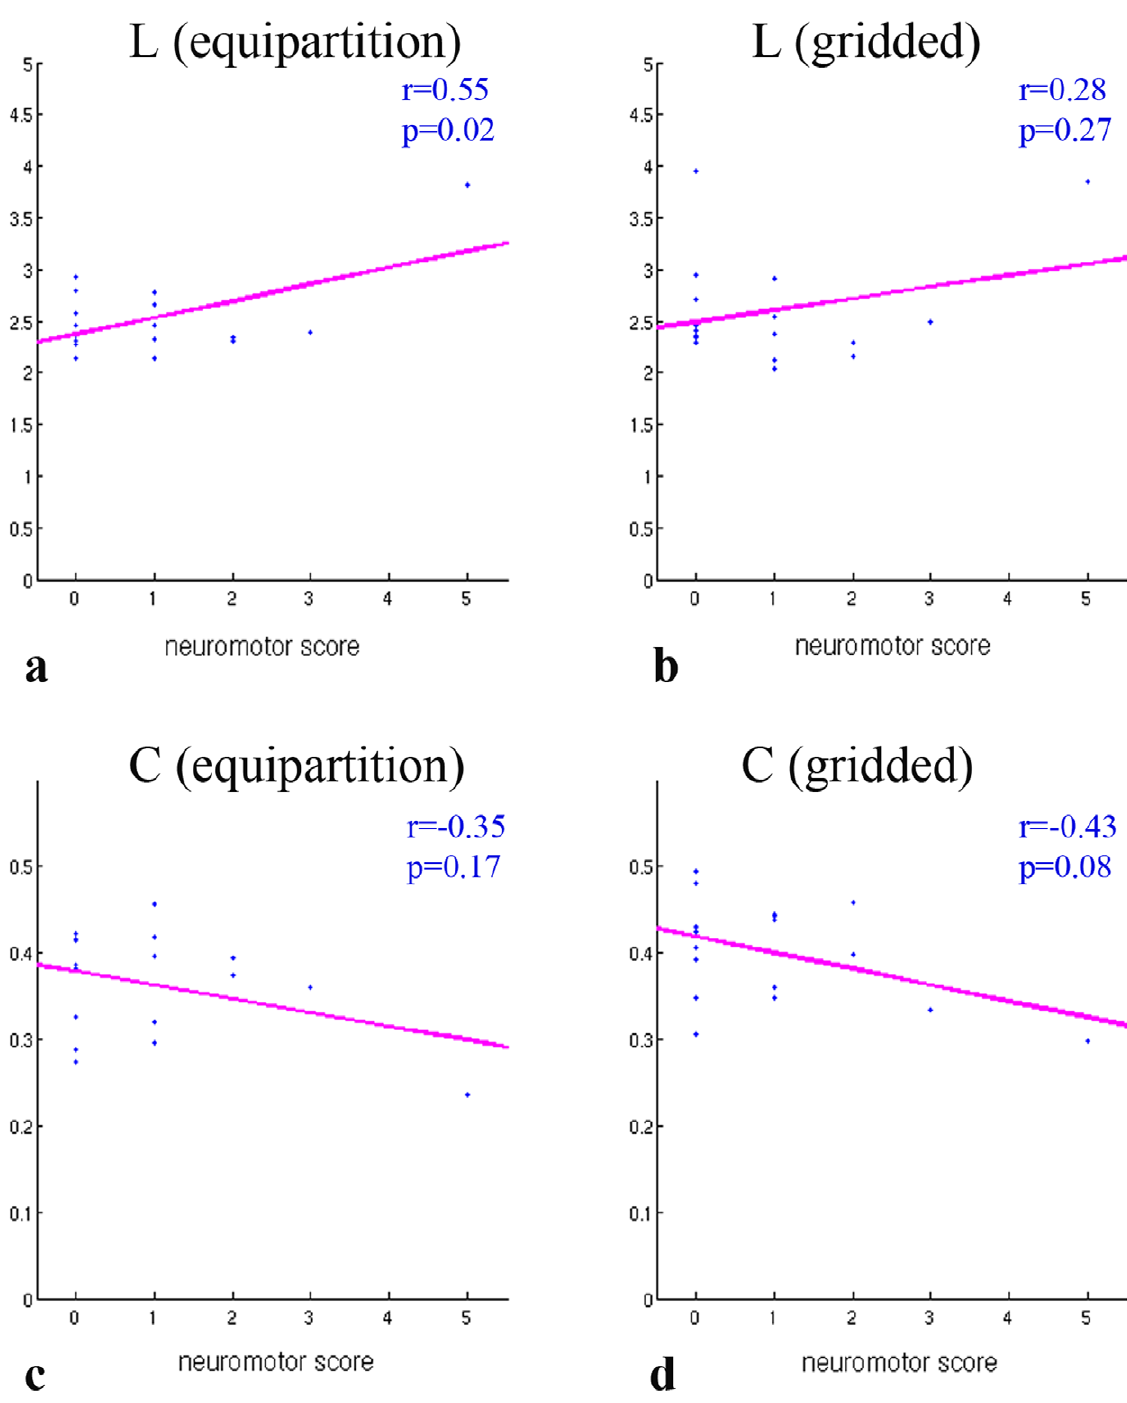
Figure 3. Correlations between Neuromotor Score and Small World Properties. Observed correlations between neuromotor score and characteristic path length (a and b) and average clustering coefficient (c and d) in babies with